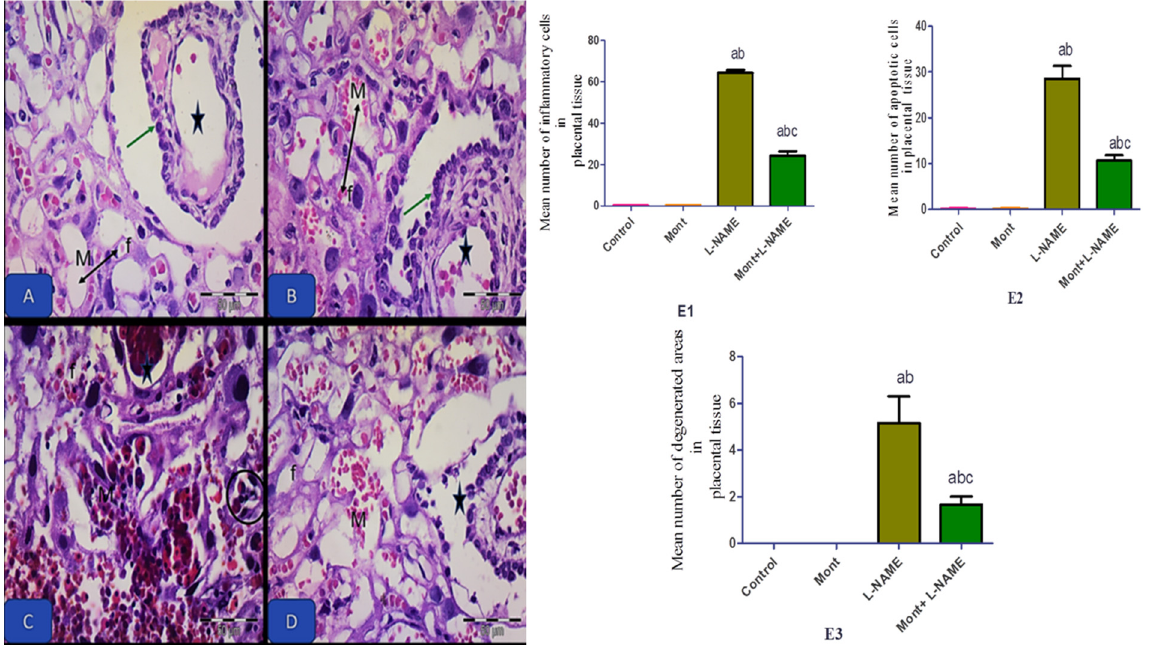
Figure 6. Effect of montelukast on the placenta in a pre-eclampsia model in rats. Photomicrographs of the control ( A ) and the Mont ( B ) groups showing full-term rat placenta at the level of labyrinth displaying normal interramal membrane and its constituents (double-headed arrow) with normal fetal capillaries (f) and normal maternal sinus (M). Notice the chorionic projection with their layers (green arrow) and inner fetal blood capillary with normal RBCs (star). ( C ) The L-NAME group showing distorted chorionic projection (star). Notice the dilated, congested maternal (M) vessels and fetal capillaries (f) and inflammatory cell infiltration (circle). ( D ) The Mont + L-NAME group showing amelioration of all previously mentioned pathological changes. Notice the apparent normal chorionic villi (star), maternal (M) vessels, and fetal capillaries (f). H&E × 400. ( E1 – E3 ) The histopathological changes in renal tissue in all groups. The data are mean ± SEM (8 rats/group). (a) Significant ( p < 0.05) difference from the control group. (b) Significant ( p < 0.05) difference from the Mont group. (c) Significant ( p < 0.05) difference from the L-NAME group. [Mont: montelukast; L-NAME: L-NG-Nitro arginine methyl ester]. H&E × 400, scale bare = 50 µm.